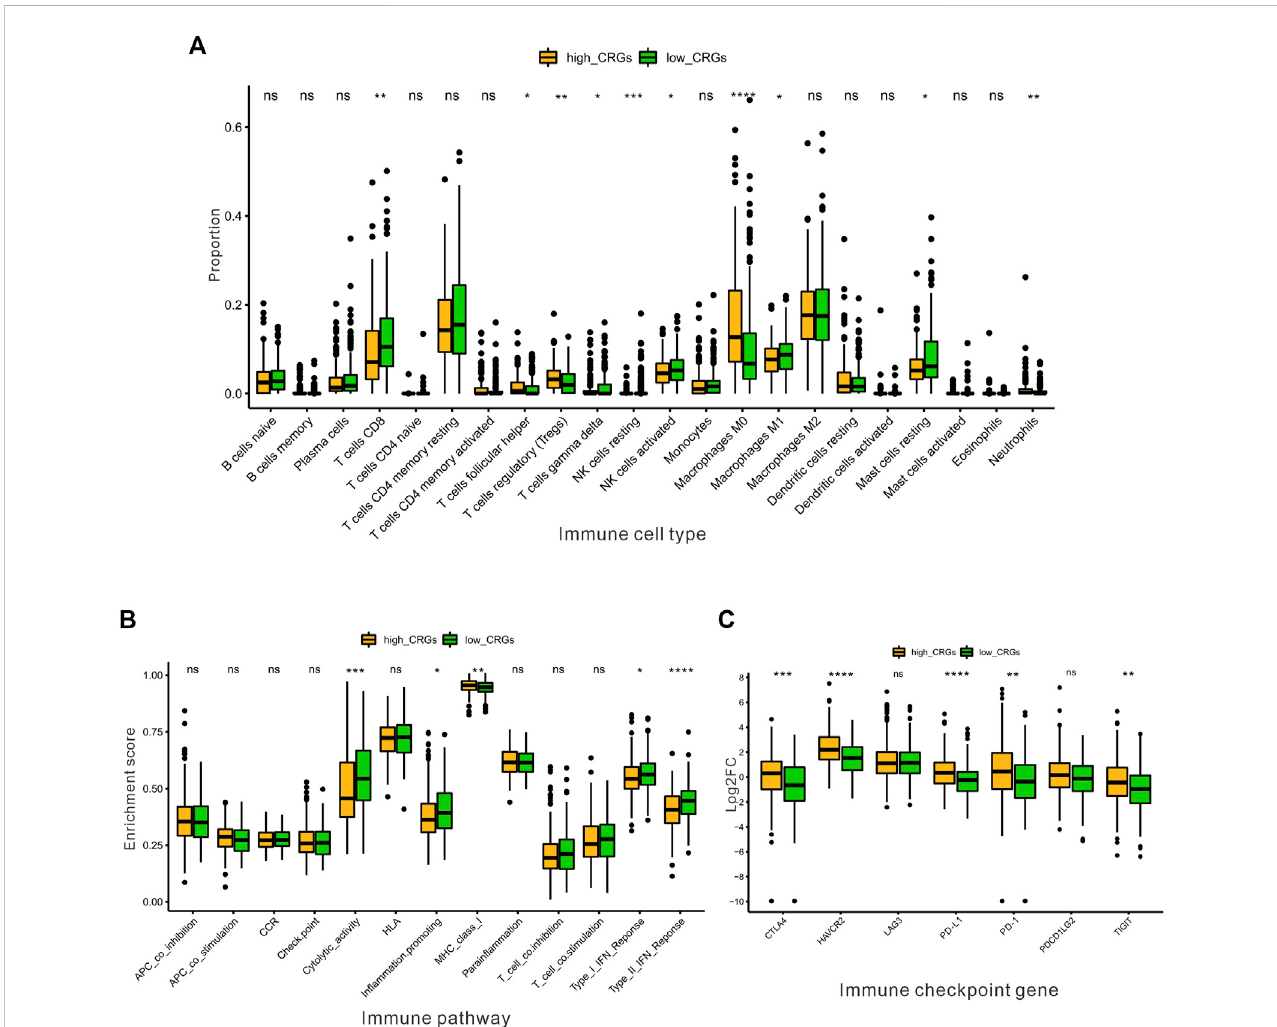
FIGURE 7 TheassociationbetweentheCRGsandimmunemicroenvironmentinHCC. (A) Theproportionofimmunein fi ltratingcellsbetweenthelowandthehigh CRGs-score subgroups by CIBERSOFT analysis. (B) The enrichment score of thirteen immune pathways between the low and the high CRGs-score groups. (C) The boxplots were utilized for visualizing the expression of seven immune checkpoint genes in the low and the high CRGs-score subgroups.